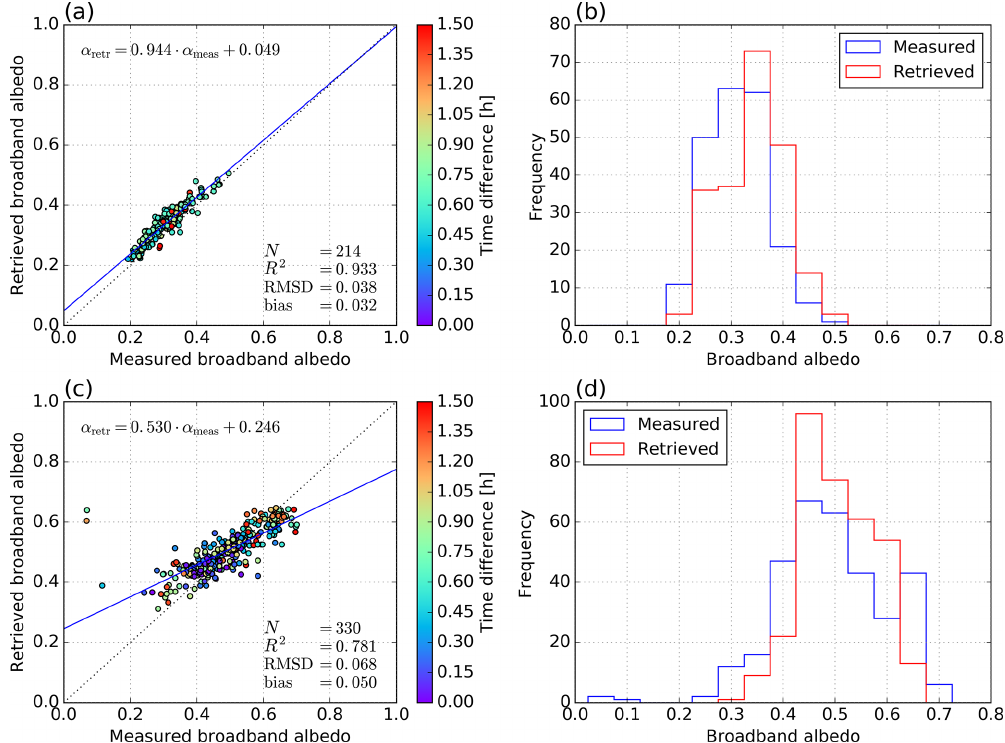
Figure 3. Scatterplot and histogram of airborne-measured and satellite-derived broadband albedo on 6 June 2008 over landfast ice (no drift) (a, b) and on 26 May and 3, 4, and 7 June 2008 over sea-ice floes (possible sea-ice drift contamination) (c, d) . The colors of the points define the time difference between airborne measurement and satellite overflight. The regression line and one-to-one line are shown as solid blue and dotted black lines,